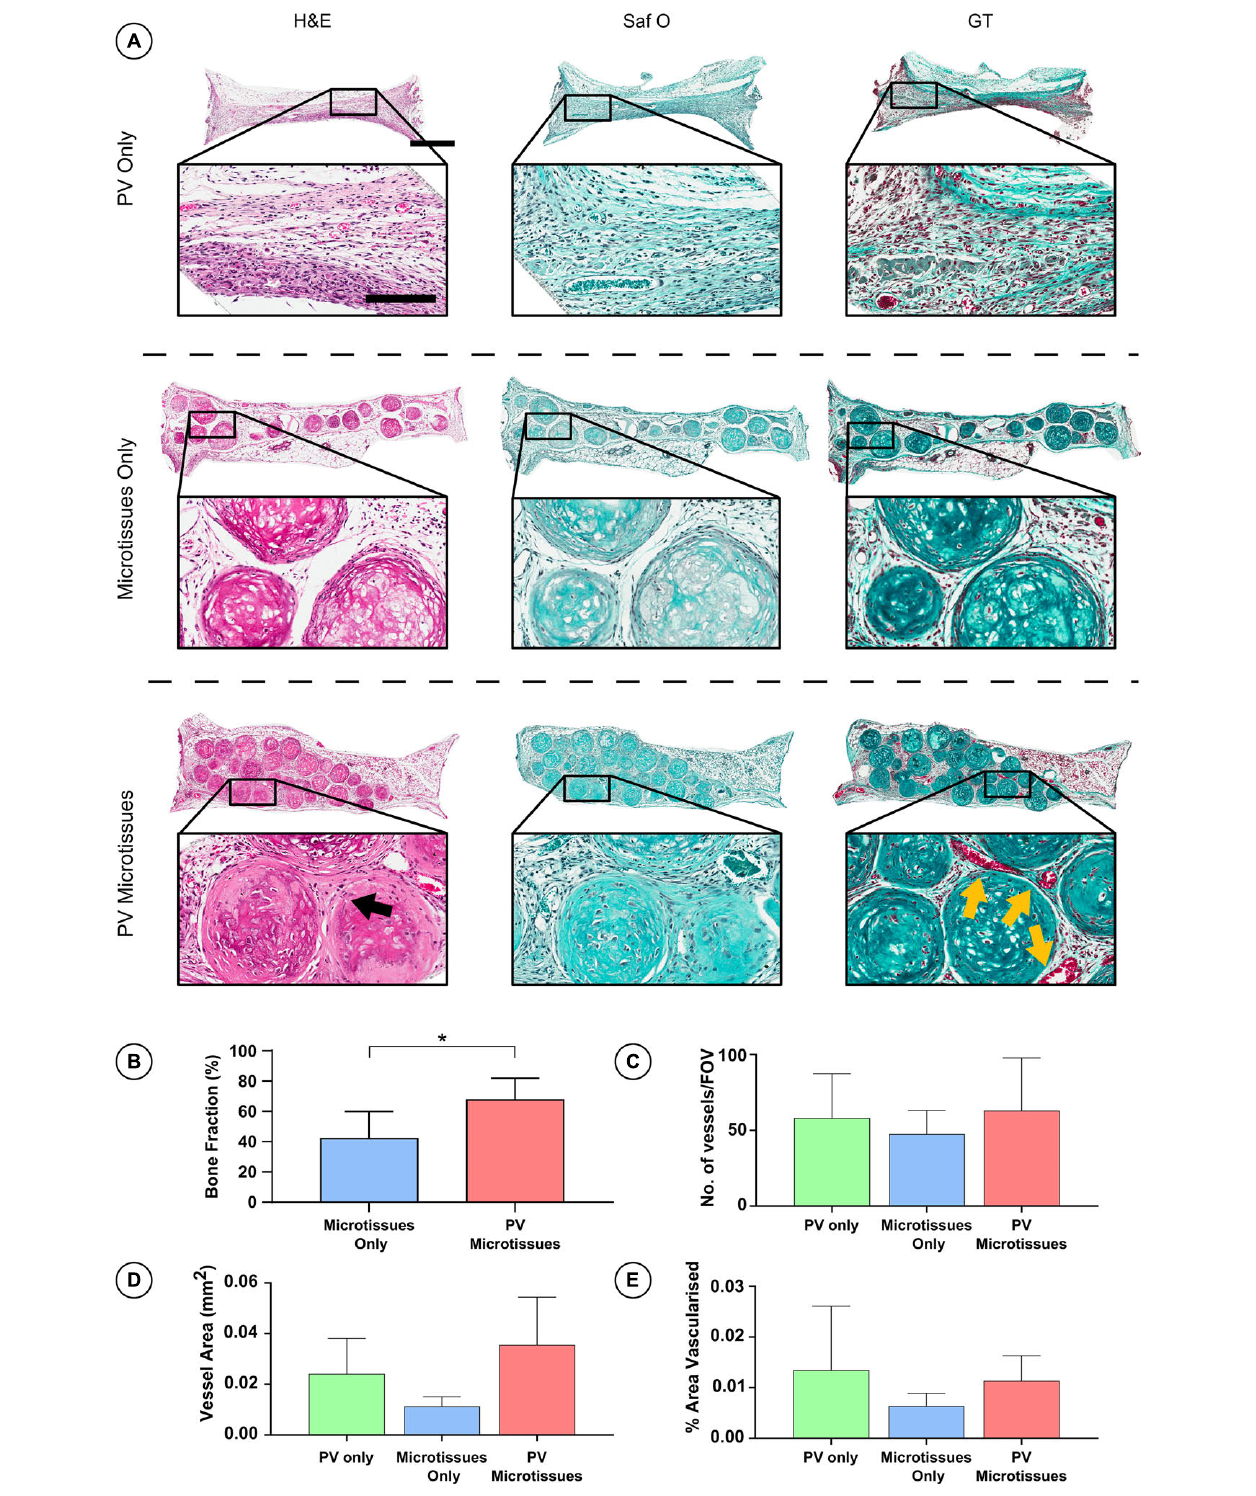
FIGURE 5 | Histological analysis of constructs 4 weeks post-implantation. (A) Haematoxylin and eosin staining (H&E), Safranin O staining (Saf O) and Goldner’s Trichome staining (GT) at 4 week Scale bar = 500 µ m for low resolution images; scale bar = 150 µ m for high resolution images (Black arrows indicate fusion and yellow arrows show blood vessels). (B) Quantification of bone fraction (C) quantification of vessel no. (D) Vessel area and (E) percentage vascularised area, *denotes significance two-way ANOVA with Tukey post hoc test, p < 0.05 ( n = 6 for PV microtissues and n = 4 for microtissue only and PV only, Mean ± SD).